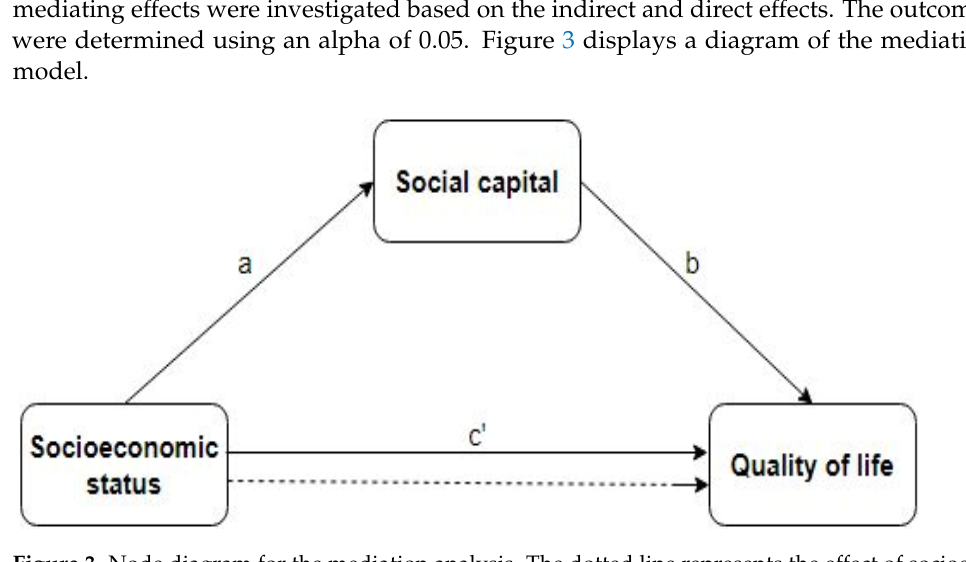
Figure 3. Node diagram for the mediation analysis. The dotted line represents the effect of socioeconomic status on quality of life, when social capital is not taken into account as a mediator. The paths a, b and c’ are direct effects.